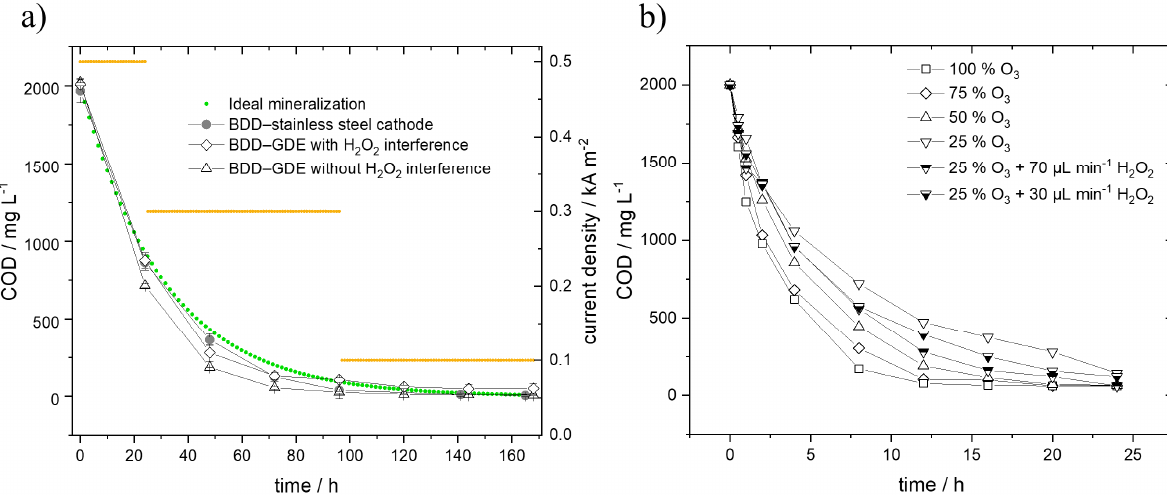
Figure 5. ( a ) COD concentrations of 18 L (cell type a) and 9 L (cell type b) during the 160 h experiments with two different electrode combinations. BDD, boron-doped diamond anode; GDE, gas diffusion electrode. The selected and adjusted current density values are shown on the 2nd y -axis. ( b ) COD degradation with O 3 and O 3 + H 2 O 2 of 2 L wastewater during 24 h experiments. The varied power settings of the O 3 generator and the H 2 O 2 dosing flow rate for the peroxone process are given in the legend above. It is noted that different treatment times were chosen due to the different system designs.